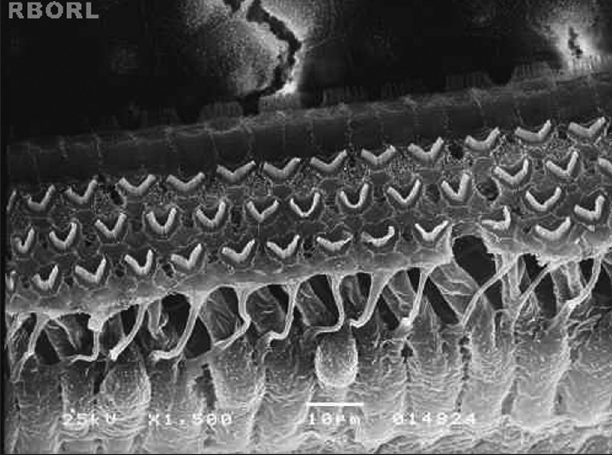
Figura 5. Fotomicrografia de órgão de Corti normal encontrado em cobaia do grupo 5, mostrando espira basal. Observe CCE não lesio- nada. Ampliação